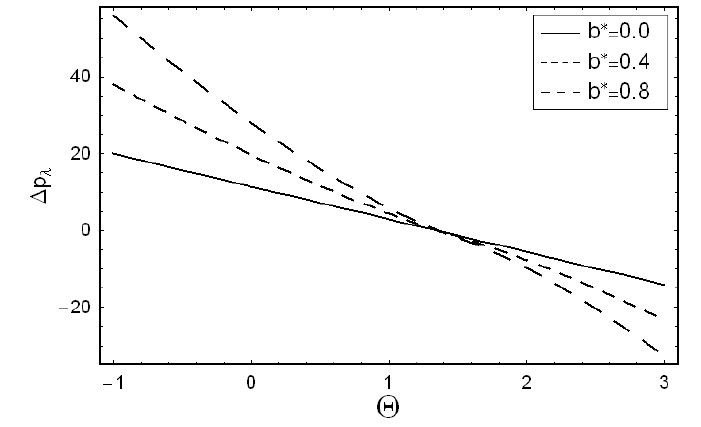
Figure 4. Variation in dp / dx for n with a = 1.0, b = 0.7, d = 1.2, b ∗ = 0.2, φ = π /2 and Θ = 1.